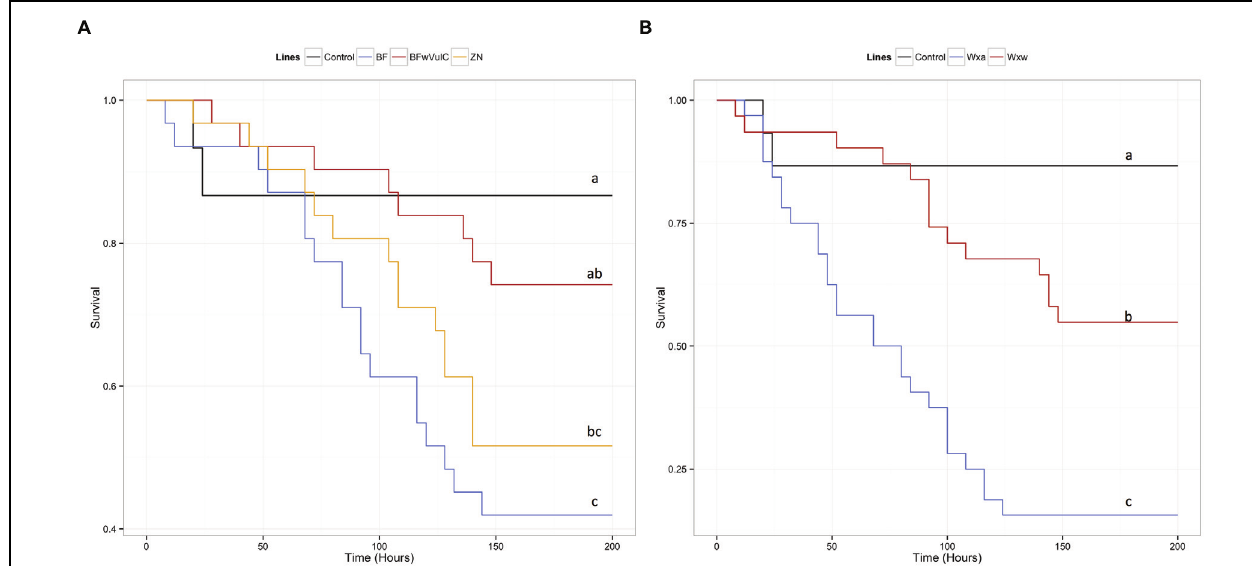
FIGURE 5 | Survival of the different A. vulgare lines when infected with L. ivanovii . A Cox proportional hazards model has been fitted using the survival data compared symbiotic and asymbiotic survival (A) BF w VulC and ZN/BF and (B) WX w /WXa. A. vulgare lines after being injected with pathogenic bacteria L. ivanovii . Control groups were injected with liquid medium (BHI). Different letters indicate significant differences between the survival curves of different lineages based on log-rank test p < 0.05.